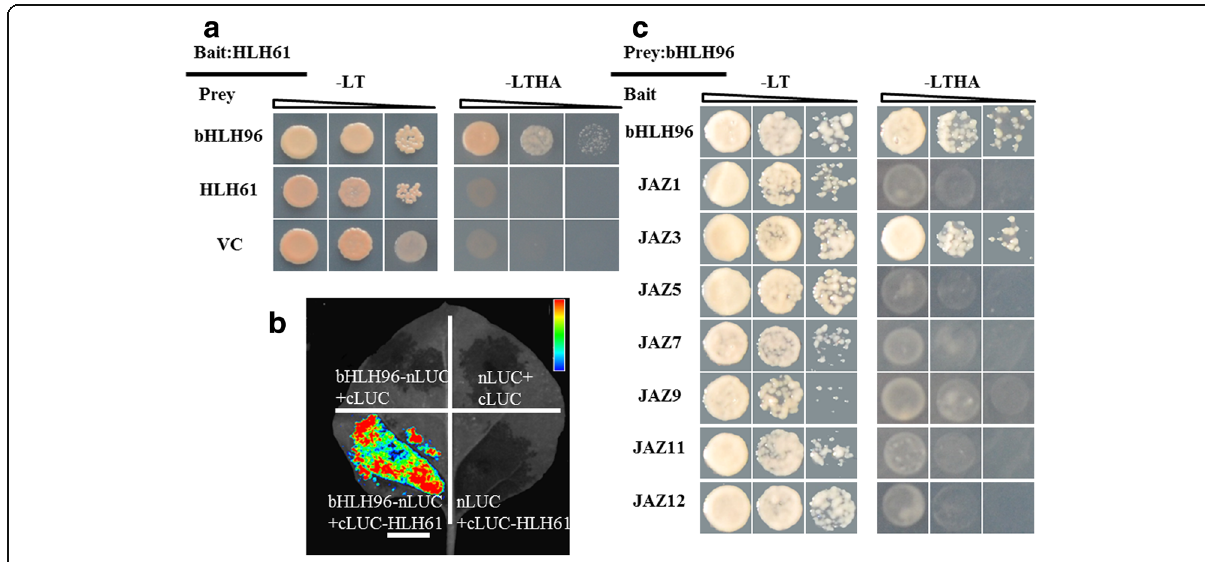
Fig. 4 Interaction analysis of OsHLH61 and OsbHLH96, and OsbHLH96 and OsJAZ3. a Yeast two-hybrid analysis of OsHLH61 and bHLH96; b BiLC assay of OsHLH61 and OsbHLH96 in tobacco. c Yeast two-hybrid analysis of OsJAZs and OsbHLH96. -LT, − LTHA indicated SD medium without Leu and Trp amino acids, and Leu, Trp, His and Ade amino acids